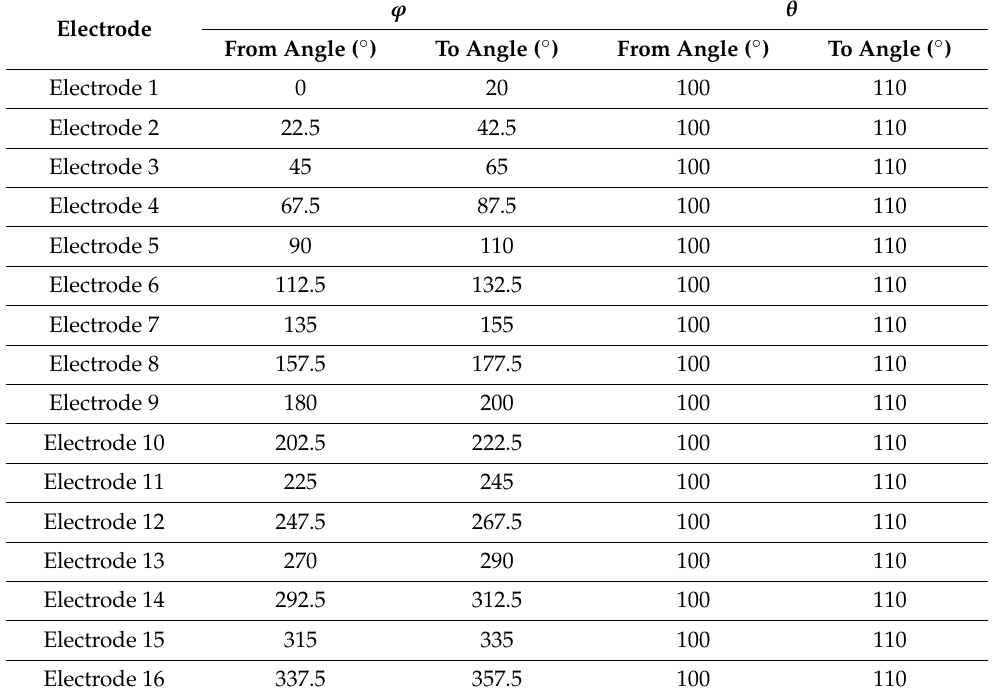
Table 3. Position of pickoffs on